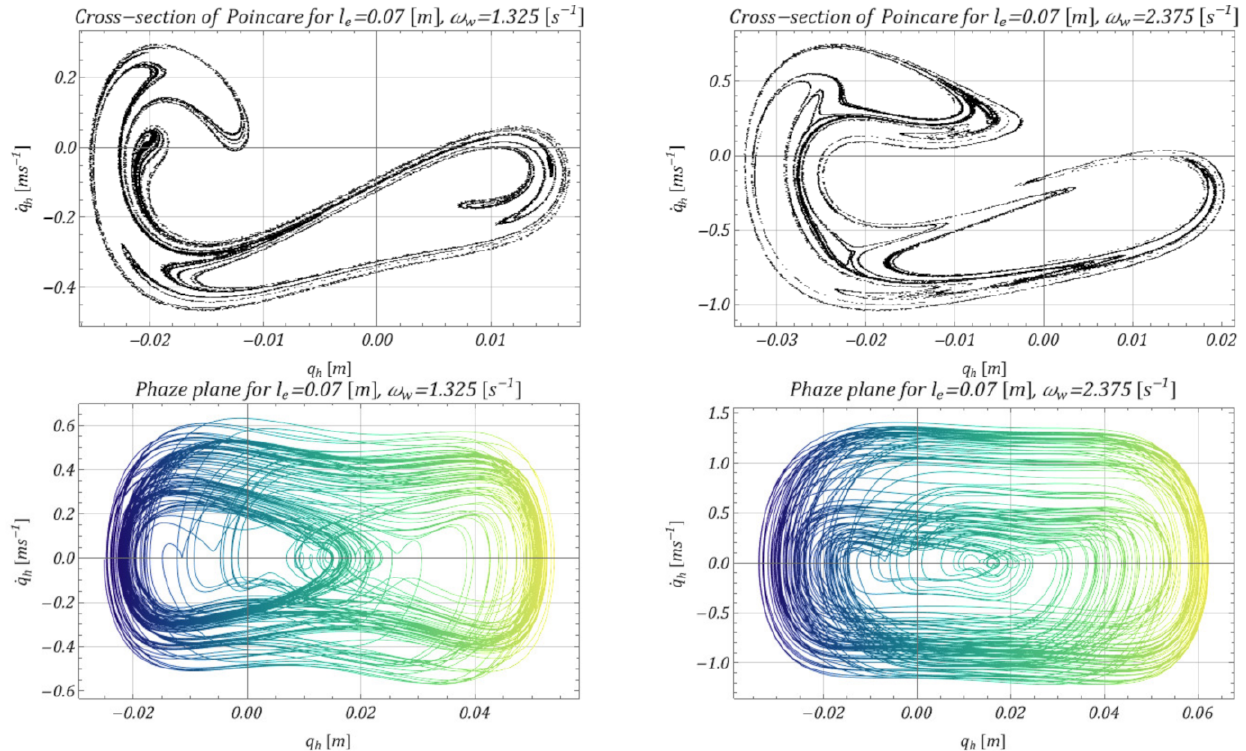
Figure 17. Phase diagrams and Poincar é maps related to selected solutions—Sample chaotic solutions for l e = 0.07 m.